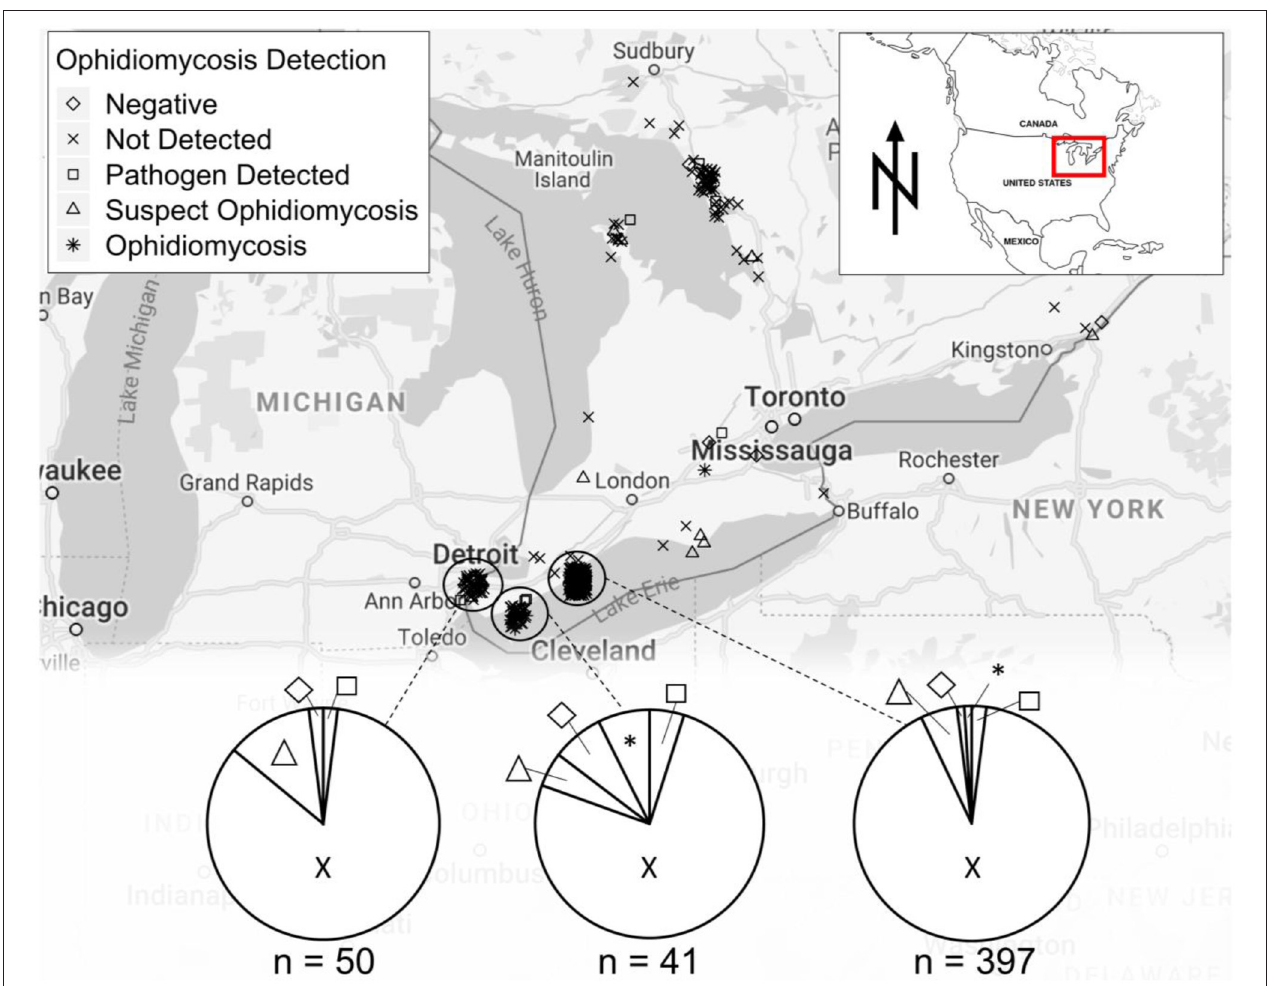
FIGURE 2 | Sampling locations for snakes tested for ophidiomycosis in the Great Lakes region of Ontario, Canada, showing diagnoses based on the criteria in Table 1 . Locations are shown for 542 snakes for which specific coordinates were available. A further 115 samples were tested and included in Table 2 but are not shown on the map as they were were submitted to the Canadian Wildlife Health Center without precise location